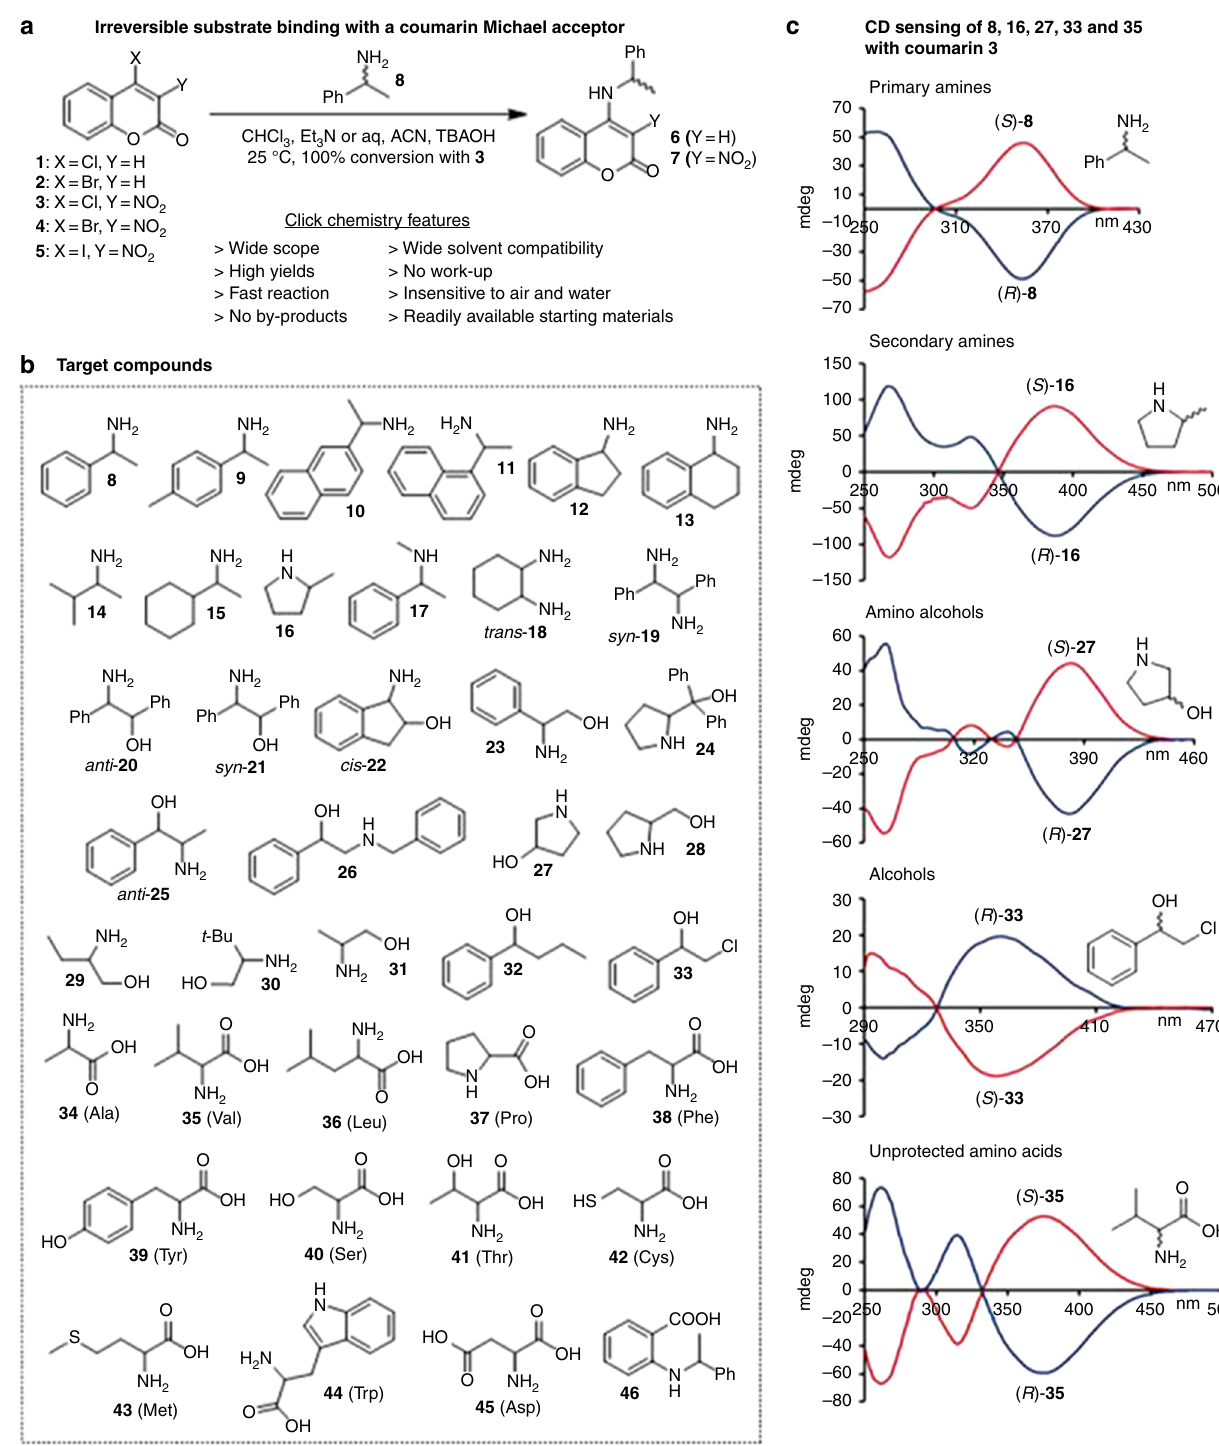
Fig. 1 Chiroptical click chemistry sensing. a Concept and features; b target scope; and c selected examples of the distinct CD signals obtained at high wavelengths using 3 as probe. All CD measurements were taken in CHCl 3 ( 8 , 16 , 27 , and 33 ) or aqueous acetonitrile ( 35 ) at